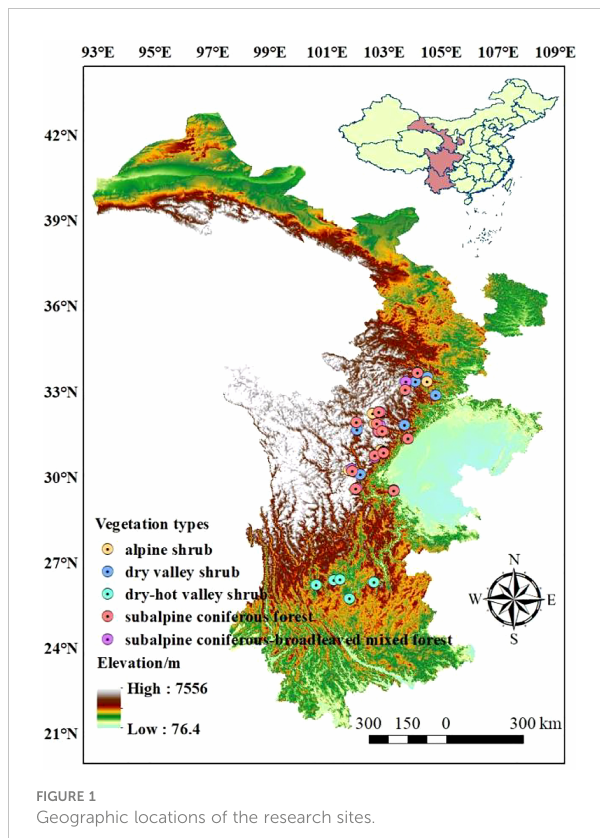
FIGURE 1 Geographic locations of the research